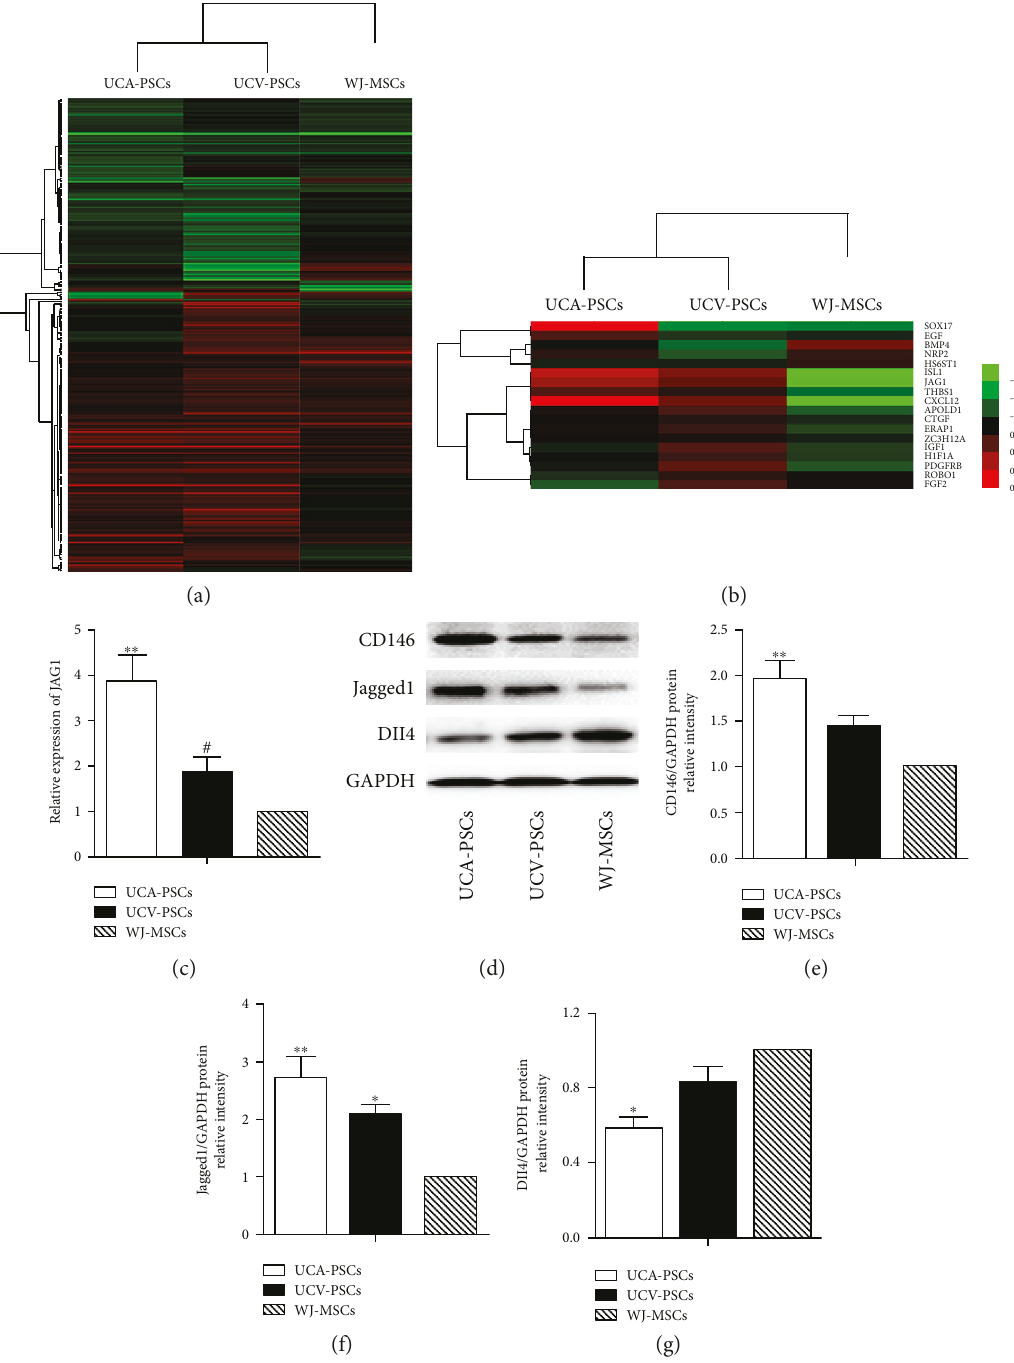
Figure 6: Expression of angiogenesis-related genes in the umbilical cord artery perivascular stem cells (UCA-PSCs), umbilical cord vein perivascular stem cells (UCV-PSCs), and Wharton ’ s jelly mesenchymal stem cells (WJ-MSCs). (a) Comparison of gene expression patterns in UCA-PSCs, UCV-PSCs, and WJ-MSCs using microarray analysis. Red indicates upregulated genes while green indicates downregulated genes. (b) Gene expression heatmaps showed fold changes in the expression of a selection of genes involved in angiogenesis. (c) mRNA levels of Jagged1 in UCA-PSCs, UCV-PSCs, and WJ-MSCs measured by qRT-PCR. ∗∗ P < 0 01 , UCA-PSCs versus WJ-MSCs. # P < 0 05 , UCV-PSCs versus UCA-PSCs. (d) Western blot analysis revealed that the CD146 and Jagged1 expression levels were the highest in UCA-PSCs, followed by UCV-PSCs and WJ-MSCs. While the Delta-like ligand (Dll4) protein displayed the opposite expression pattern in these three cell types. Quantitative analysis of CD146 (e), Jagged1 (f), and Dll4 (g) protein expression levels in UCA-PSCs, UCV-PSCs, and WJ-MSCs. Data are representative of three independent experiments performed in triplicate, and the expression of targeted protein was relative to the expression of GAPDH protein. ∗∗ P < 0 01 , versus WJ-MSCs. # P < 0 01 , UCV-PSCs versus UCA-PSCs. ∗ P < 0 05 , versus